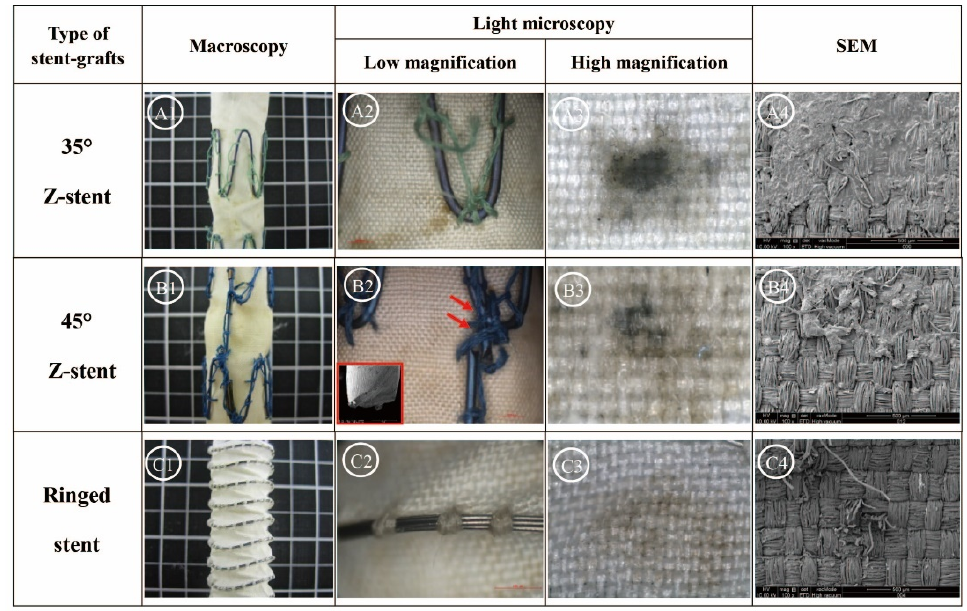
Figure 7. Twist tests of stent ‐ grafts after 168 h. The stent ‐ grafts supported by Z ‐ stents are damaged to various levels. No holes are observed but a vertical strut of S5 is broken and numerous sutures are broken. The abrasion of the fabric is visible in the Z ‐ stent devices, whereas it is well preserved in the ringed stent ‐ grafts. ( A1 , B1 , C1 ) Gross observations; ( A2 , B2 , C2 ) Observation in light microscopy with low magnifications; ( A3 , B3 , C3 ) Observation in light microscopy with high magnification (40×); ( A4 , B4 , C4 ) Observation in SEM (100×).